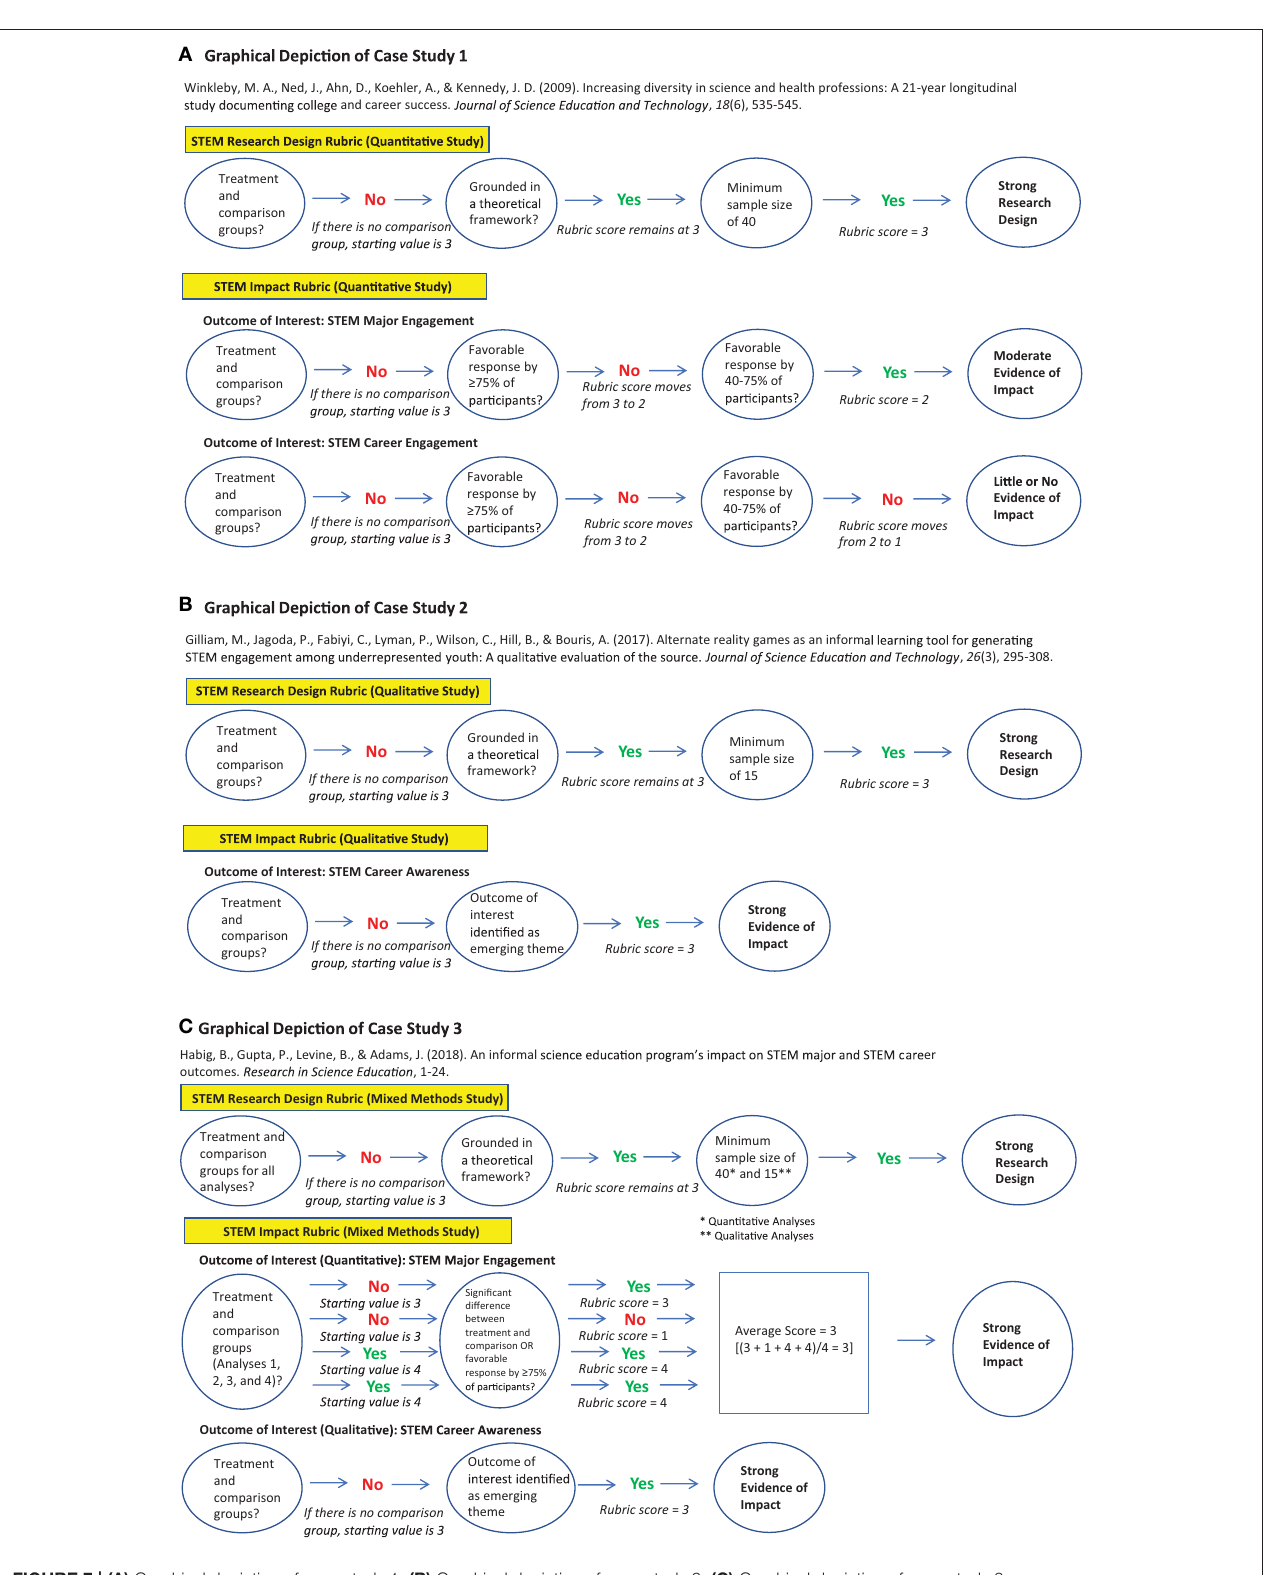
FIGURE 7 | (A) Graphical depiction of case study 1. (B) Graphical depiction of case study 2. (C) Graphical depiction of case study